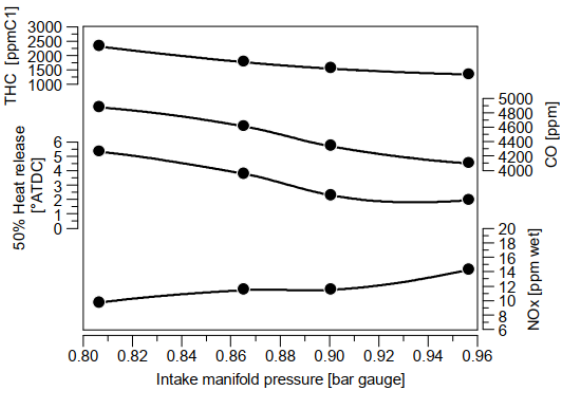
Fig. 8 Effect of an increase of intake pressure on BMEP, CA50, HC and NO X